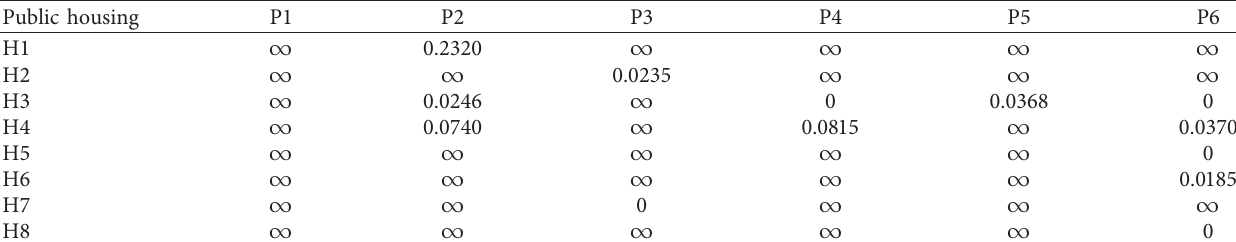
Table 4: Actual output information for attribution characteristics of 8 public housings and 6 security objects.